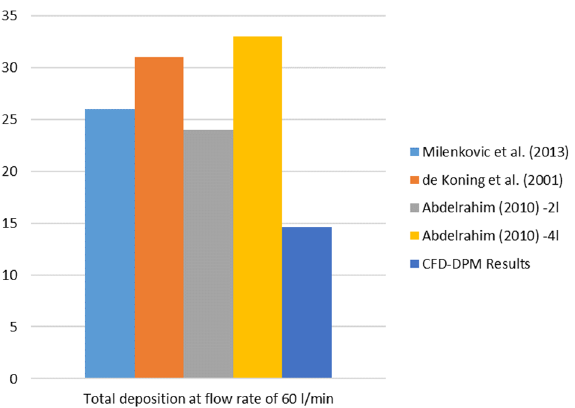
Figure 8. Comparison of the total particle deposition (%) for an airflow rate of 60 l/min.